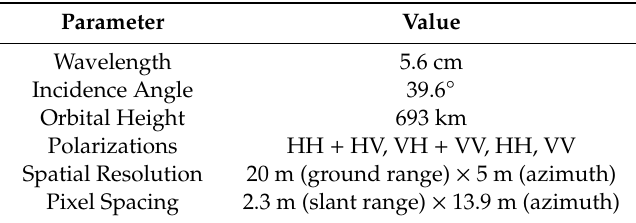
Table 1. The parameters of the Sentinel-1A SAR data (ESA, 2013).